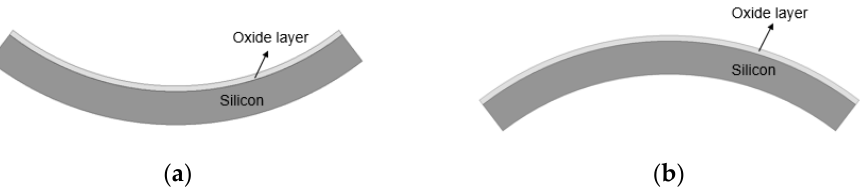
Figure 9. ( a ) Wafer deformed in a concave shape when the residual film stress is the tensile stress.